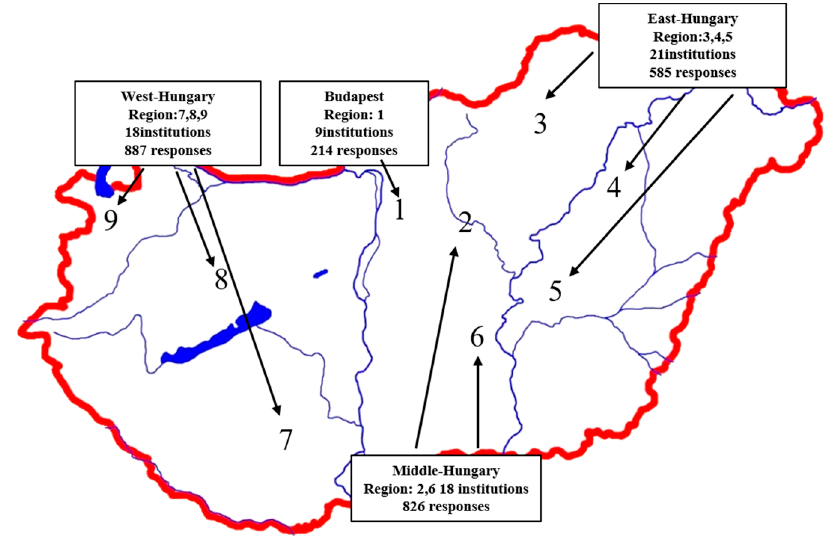
Figure 1. Responses according to geographical locations, institutions and responses.